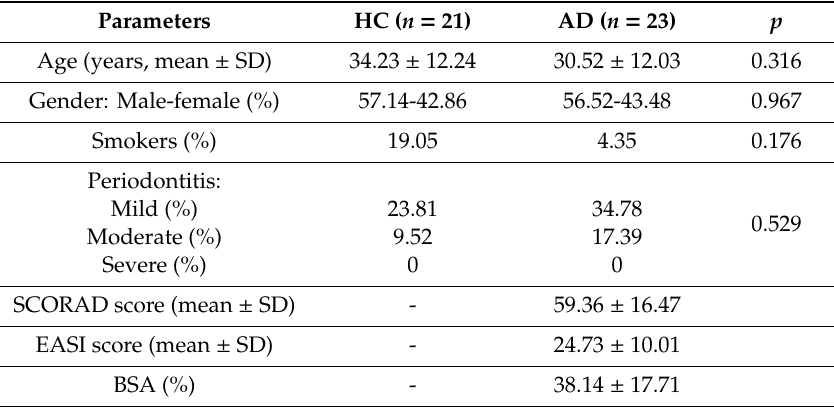
Table 1. Demographic data and smoking habits of all study individuals.